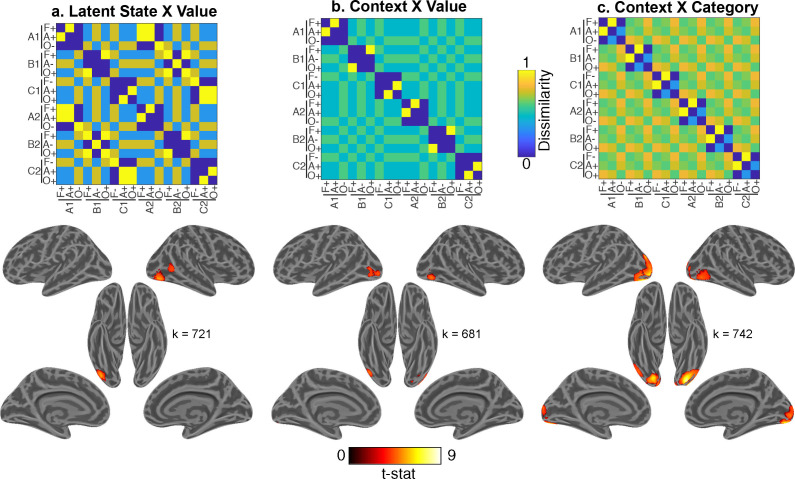
Whole-brain searchlight analyses for interaction terms.(a) Results showing where pattern activity was modulated by the negative interaction of latent state and value. Nuisance regressors for interactions between contexts and (b) value and (c) categories. All maps are defined with a cluster forming threshold of p<0.001 and corrected for multiple comparisons with permutation tests for defining a cluster extent threshold at p<0.05.